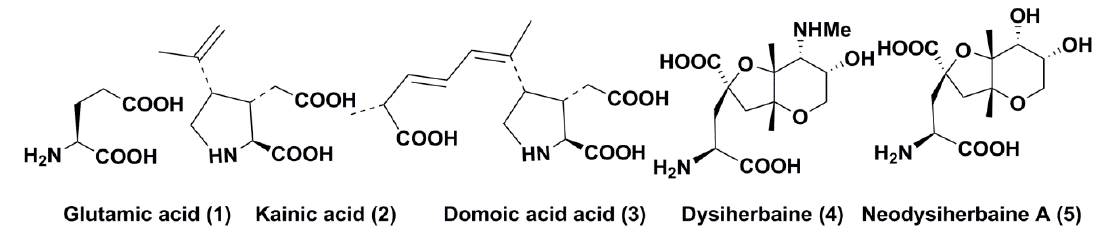
Figure 1. Chemical structures of glutamic acid ( 1 ) and marine excitatory acids ( 2 – 5 ).